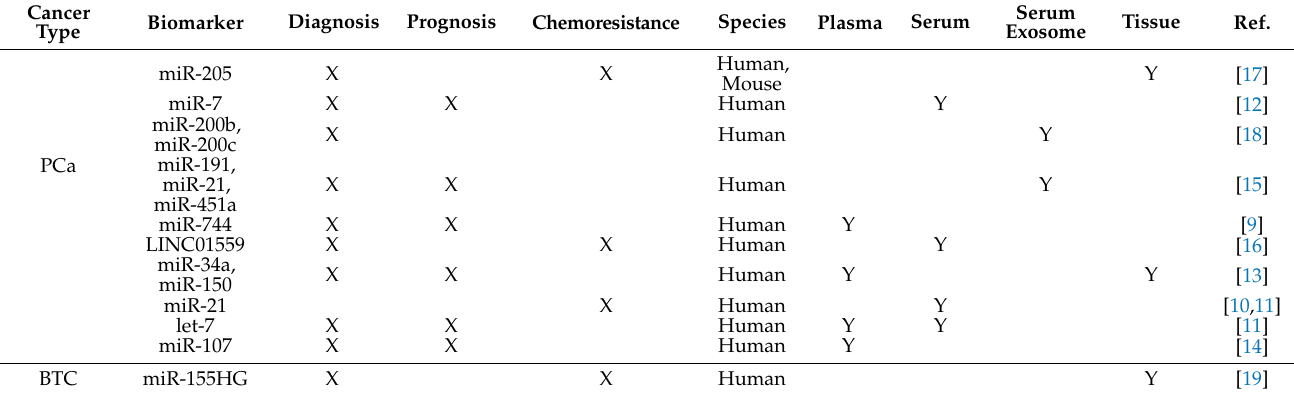
Table 1. Biomarker candidates for non-coding RNA identified in the present systematic